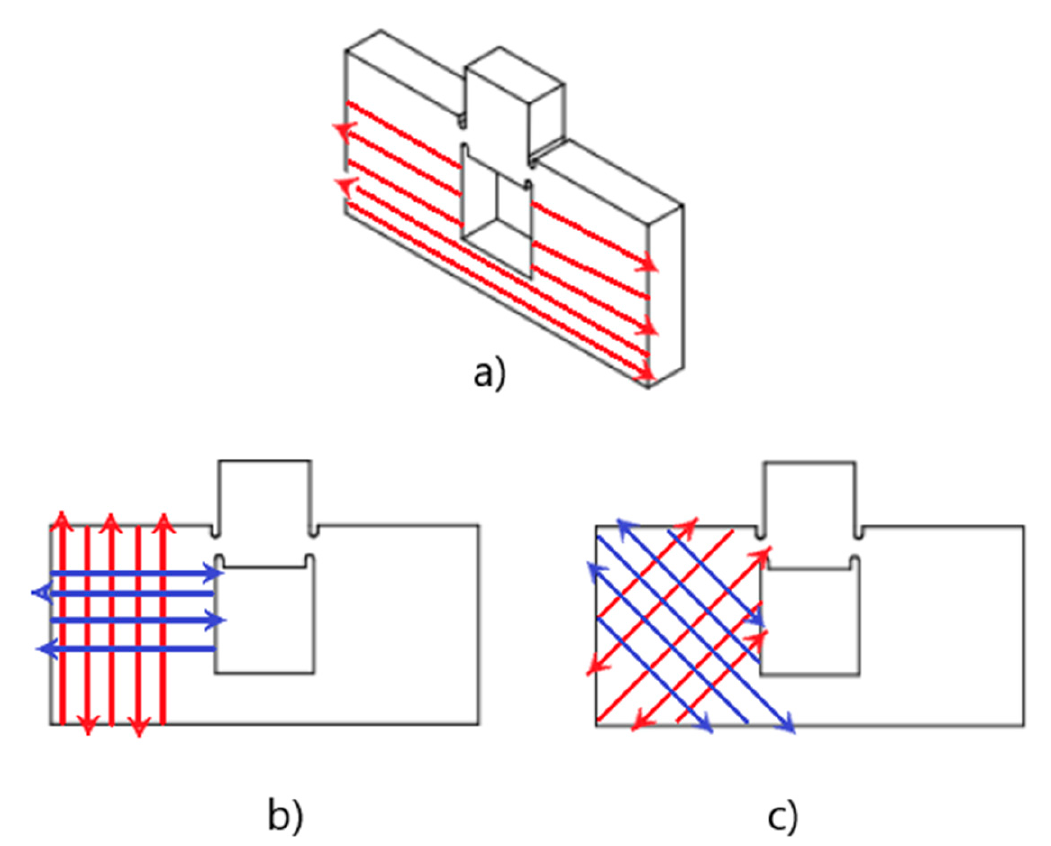
Figure 1. Sketch of specimen configurations with their respective raster orientation sequences ( a ) Vertical; ( b ) 0 ◦ /90 ◦ , with 0 ◦ oriented in blue and 90 ◦ oriented in red; ( c ) 45 ◦ / − 45 ◦ with 45 ◦ oriented in red and − 45 ◦ in blue. Table 1. Printing parameters utilized in this